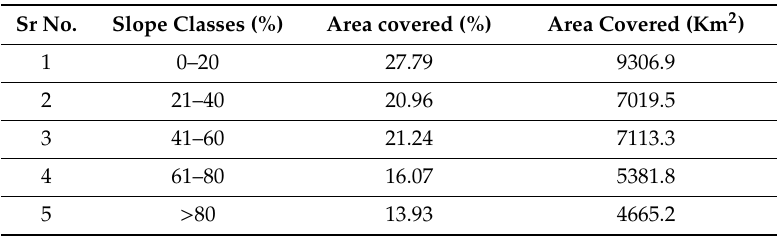
Table 4. SWAT slope classes in Mangla